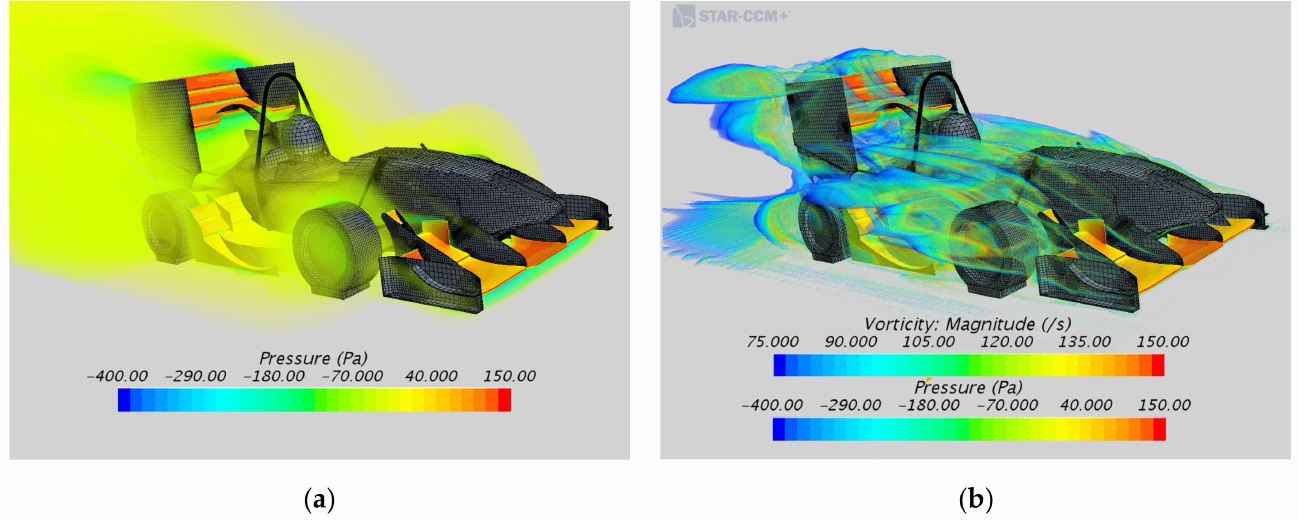
Figure 5. Distribution of low-pressure area and turbulence of the whole vehicle. ( a ) Side wing is exposed to the relatively low-pressure zone; ( b ) side wing is subjected to air flow with high